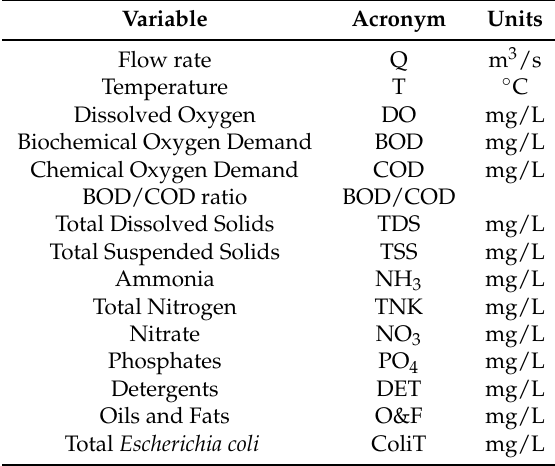
Table 2. Studied water quality parameters for the case study of the Machángara River.